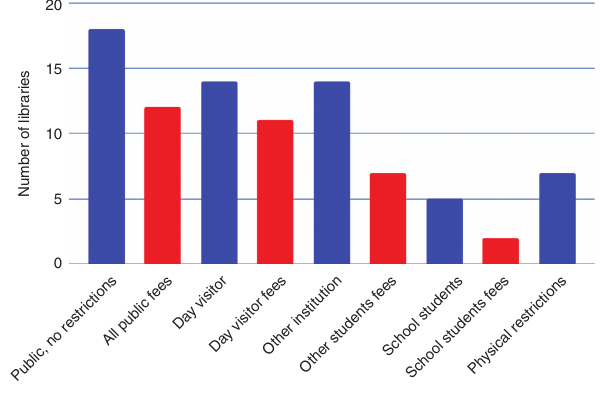
Fig. 3: External, public membership categories and fees charged; physical access